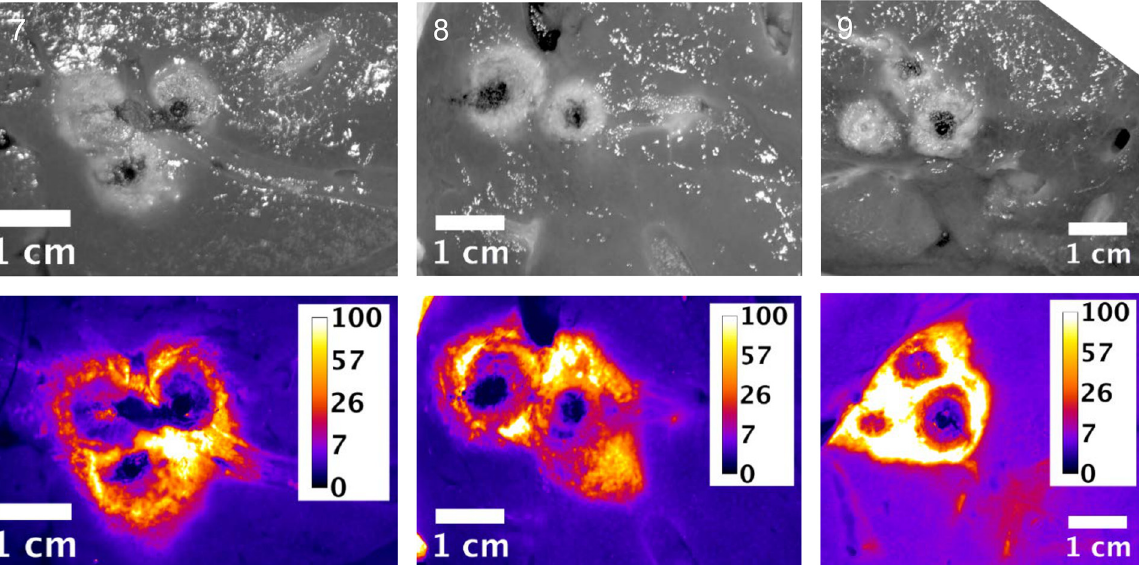
Fig 4. Plain and fluorescent images of ablation zone in pigs in Study B, group 2. Each pig received three sequential, overlapping 12 minute ablations and 3 minute cool down between ablations (total time = 45 minutes) with the Covidien device. Scale is μ g/g doxorubicin.